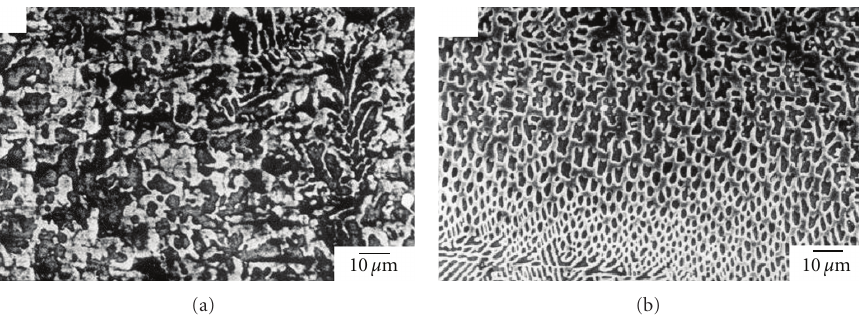
Figure 1: Scanning electron micrographs of the alloyed zone formed at the interface of direct laser clad Co on Ti, (a) without Cu and (b) with Cu coating at a thickness of 30 μ m.